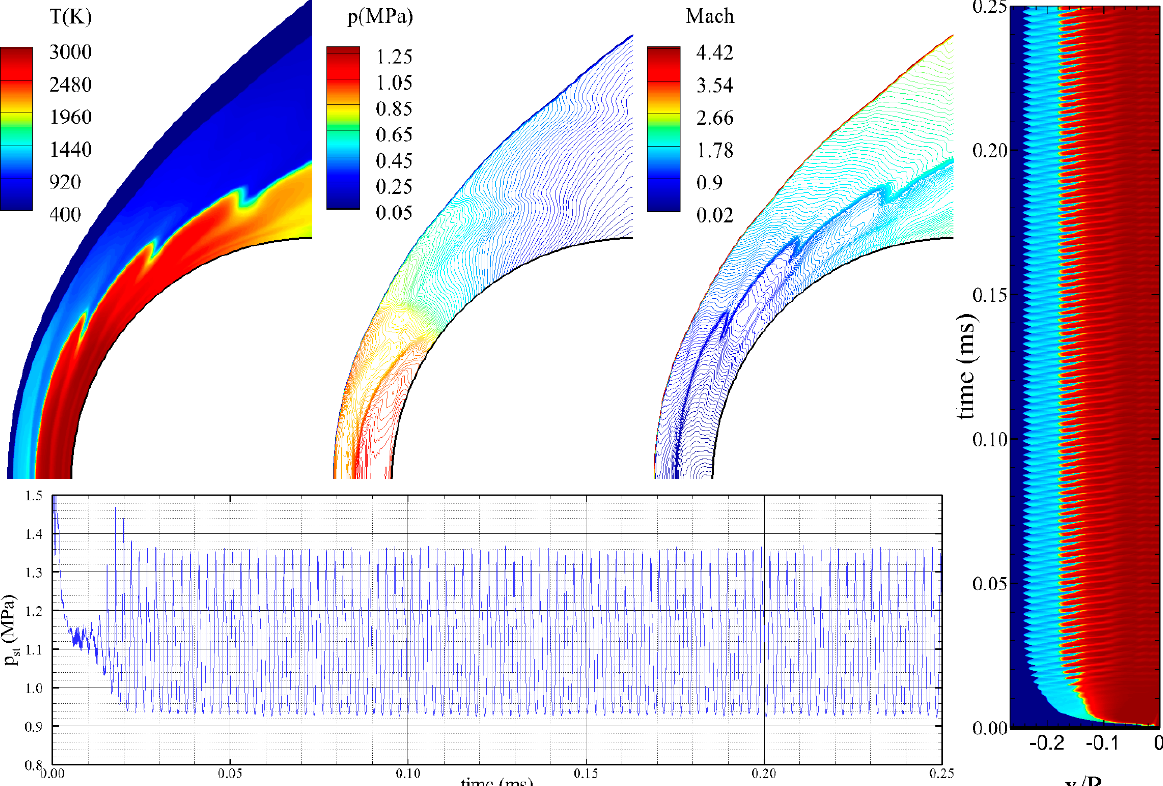
Figure 9. Overview of the numerical results for regularly oscillating shock-induced combustion case flying at Mach 4.48. Color scale of x-t diagram is the same as the contour plot.